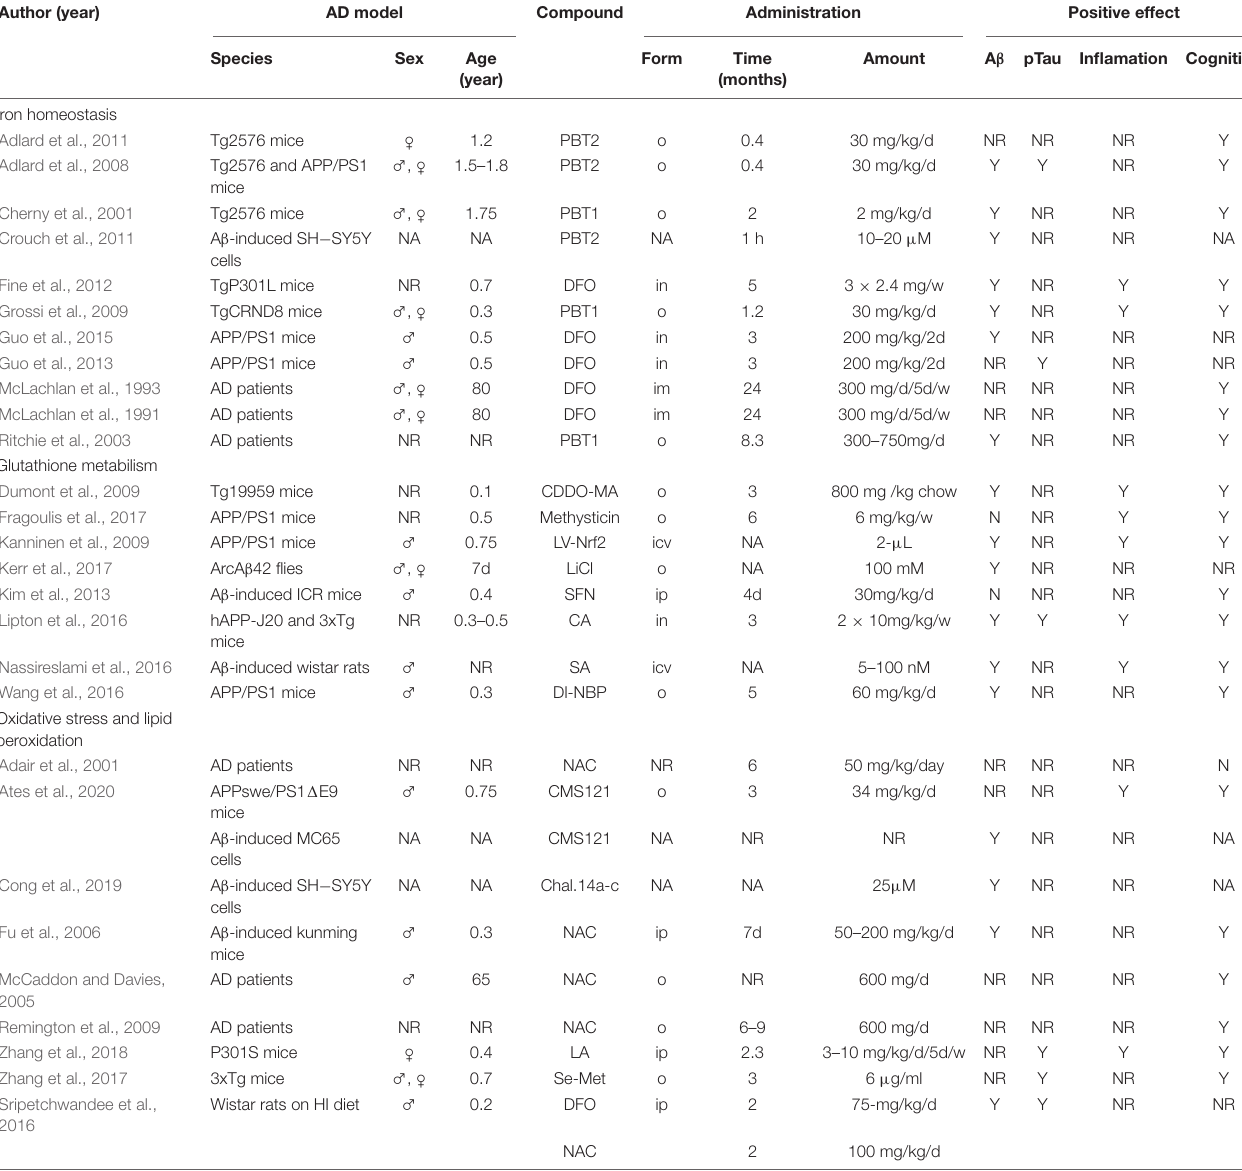
TABLE 4 | Characteristics of included articles assessing therapeutic options to prevent ferroptosis in AD stratified by mechanisms involved in